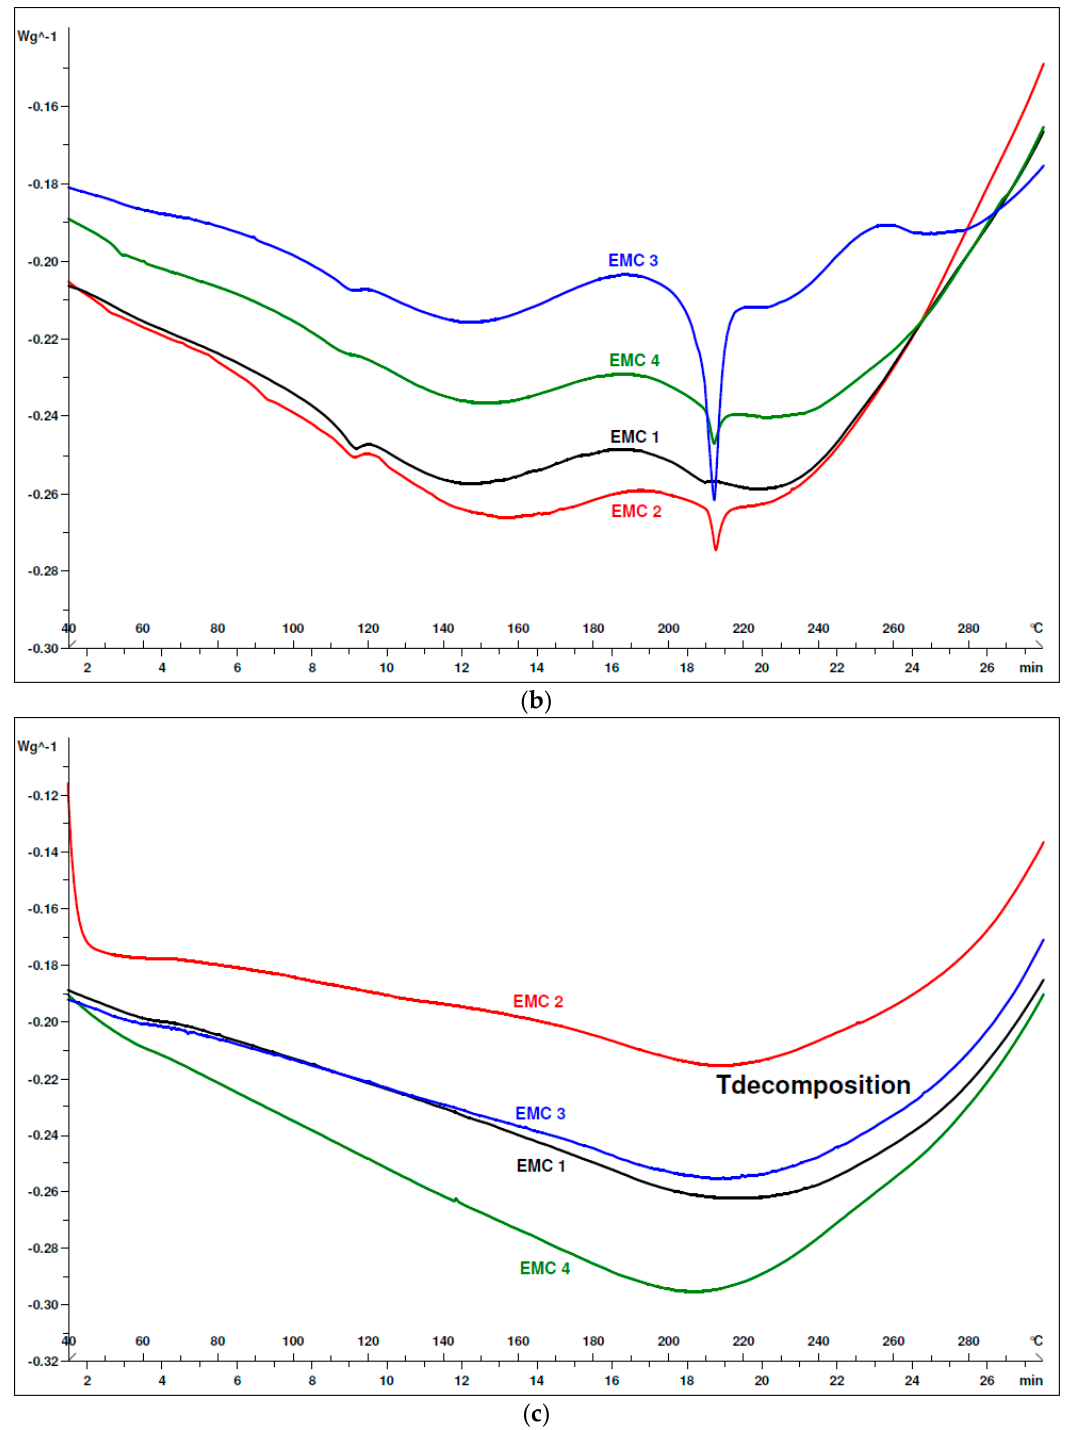
Figure 3. ( a ) Differential Scanning Calorimetry ( DSC) thermogrames of prepared epoxy molding compounds (EMC) granulates before molding process; ( b ) DSC thermogrames of prepared EMC products after molding process; and, ( c ) DSC curves thermogrames of prepared EMC products after post curing process.